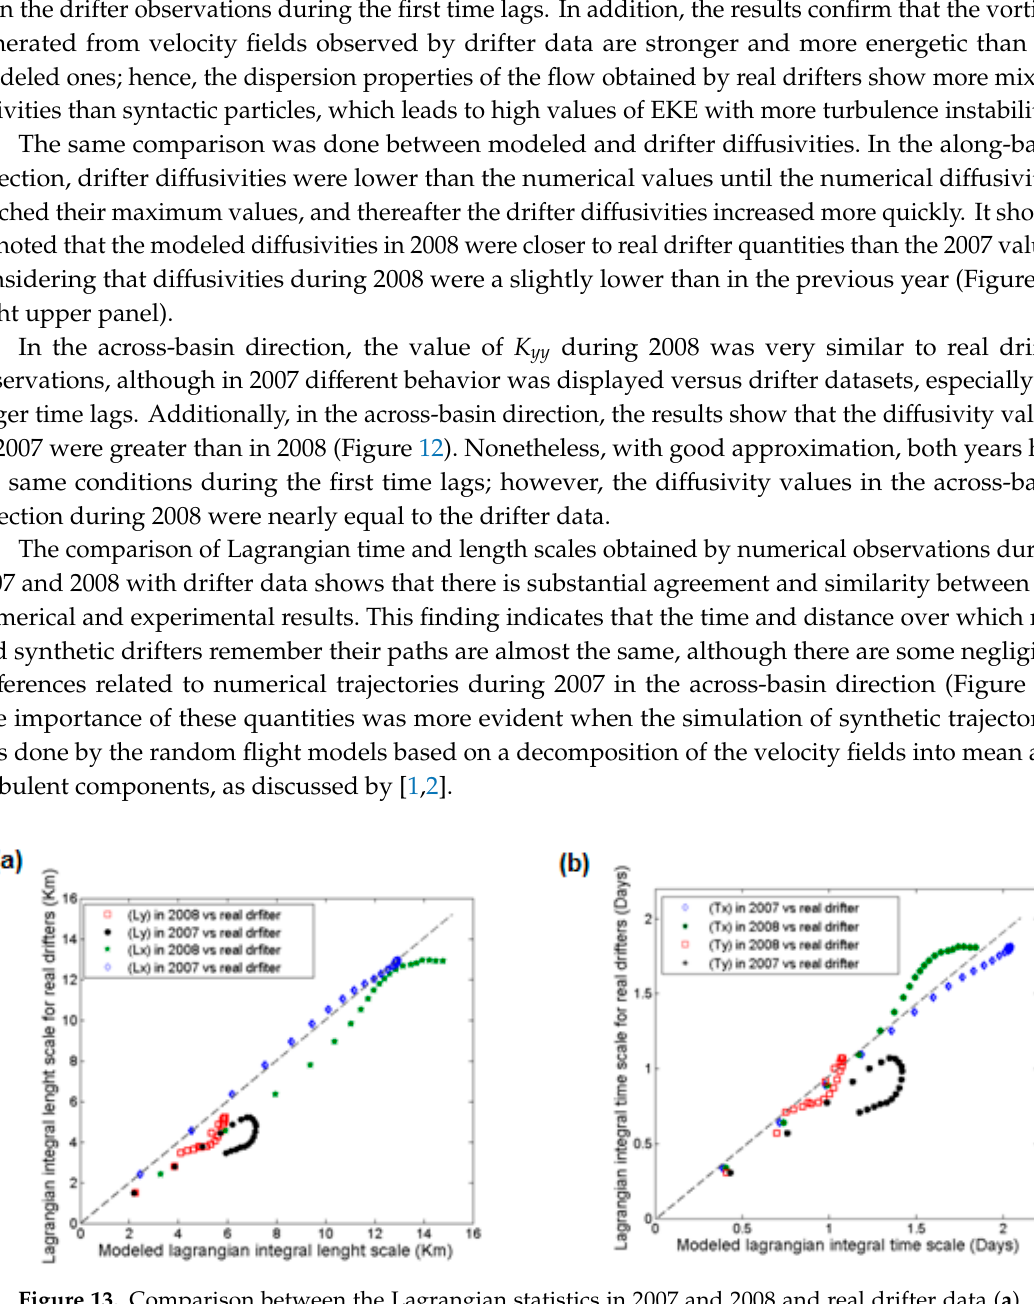
Figure 13. Comparison between the Lagrangian statistics in 2007 and 2008 and real drifter data ( a ) velocity covariance ( b ) diffusivity, Lagrangian integral length scale, and Lagrangian integral time scale).